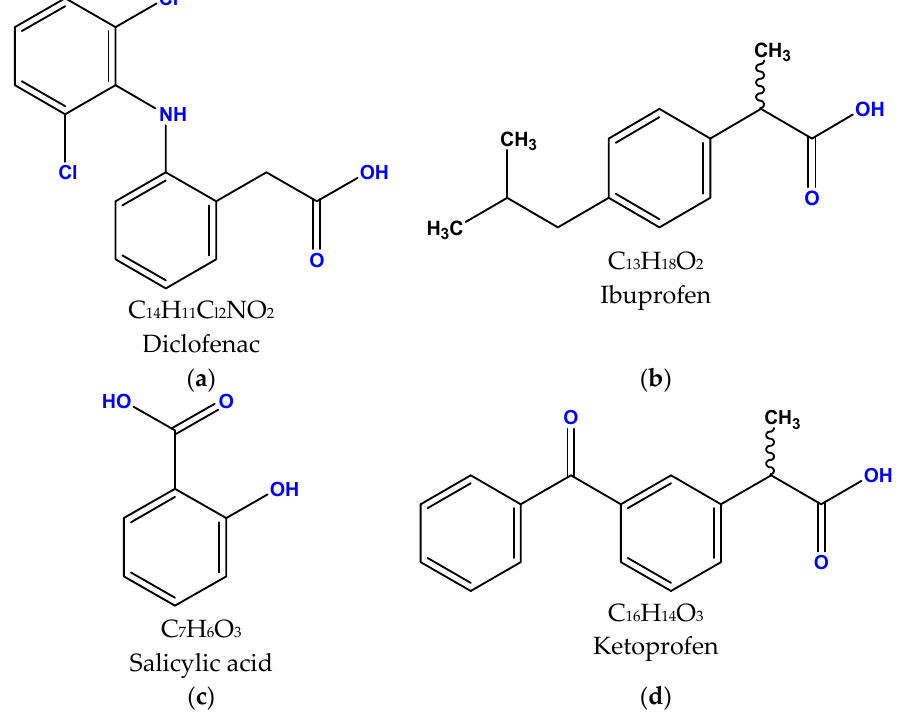
Figure 1. Molecular formula and chemical structures of the used pharmaceutical compounds: ( a ) diclofenac, ( b ) ibuprofen, ( c ) salicylic acid and ( d ) ketoprofen.